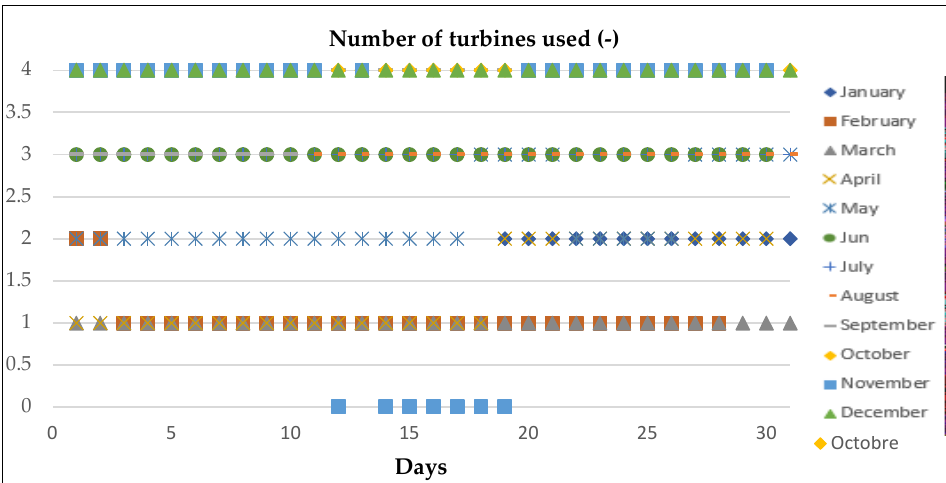
Figure 10. Curve of the number of turbines used.